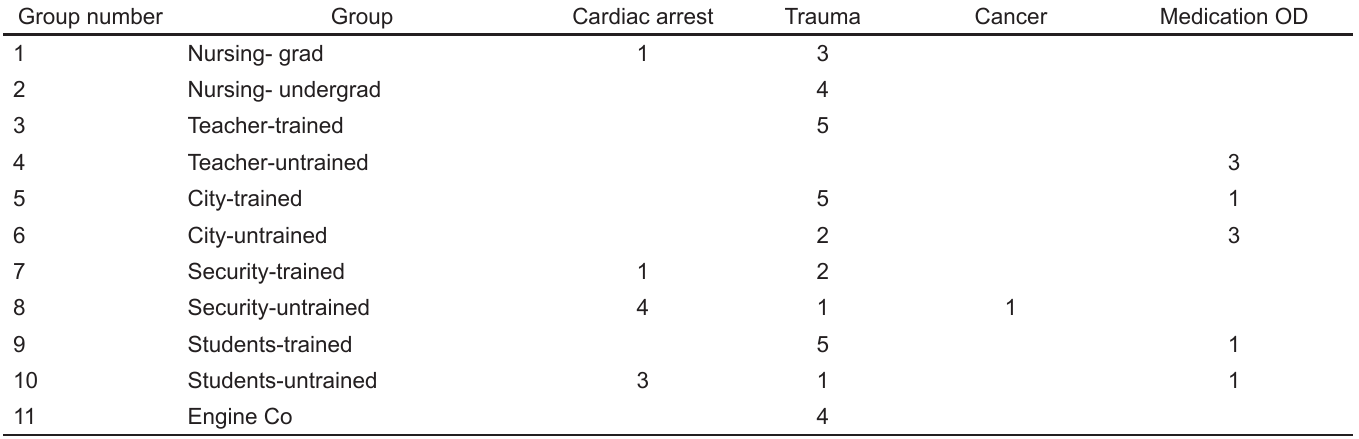
Table 1. Answers to Question 1 of the pre-test, organized by group number.